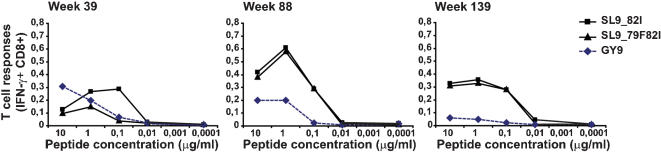
Characterization of the HLA-A2-restricted SL9-specific (82I and 79F82I autologous variants) and HLA-A1-restricted GY9 specific CTL responses in OP428.Peptide titration of the autologous epitope variants was conducted to evaluate the functional avidity of the responses over time, at weeks 39, 88, and 139 from estimated infection. The CFC assay was used to measure the production of gamma interferon by antigen specific CD8+ T cells, with the indicated peptides in 10-fold dilutions.